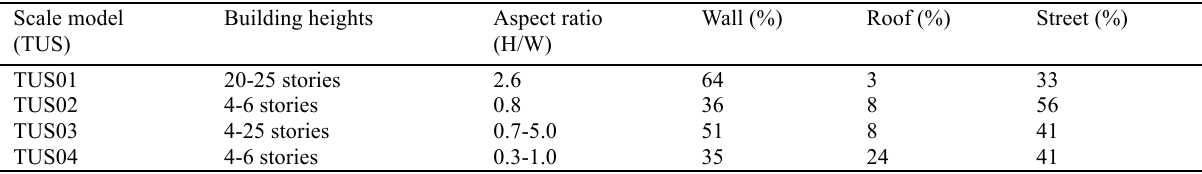
Fig.1 . Scale models of four typical urban surfaces (TUS). Table.1. The geometric structure parameter information of four types of urban underlying surface model includes the building type, building height and street width ratio (H/W), and the surface area of the ground surface, which accounts for the weight of the whole